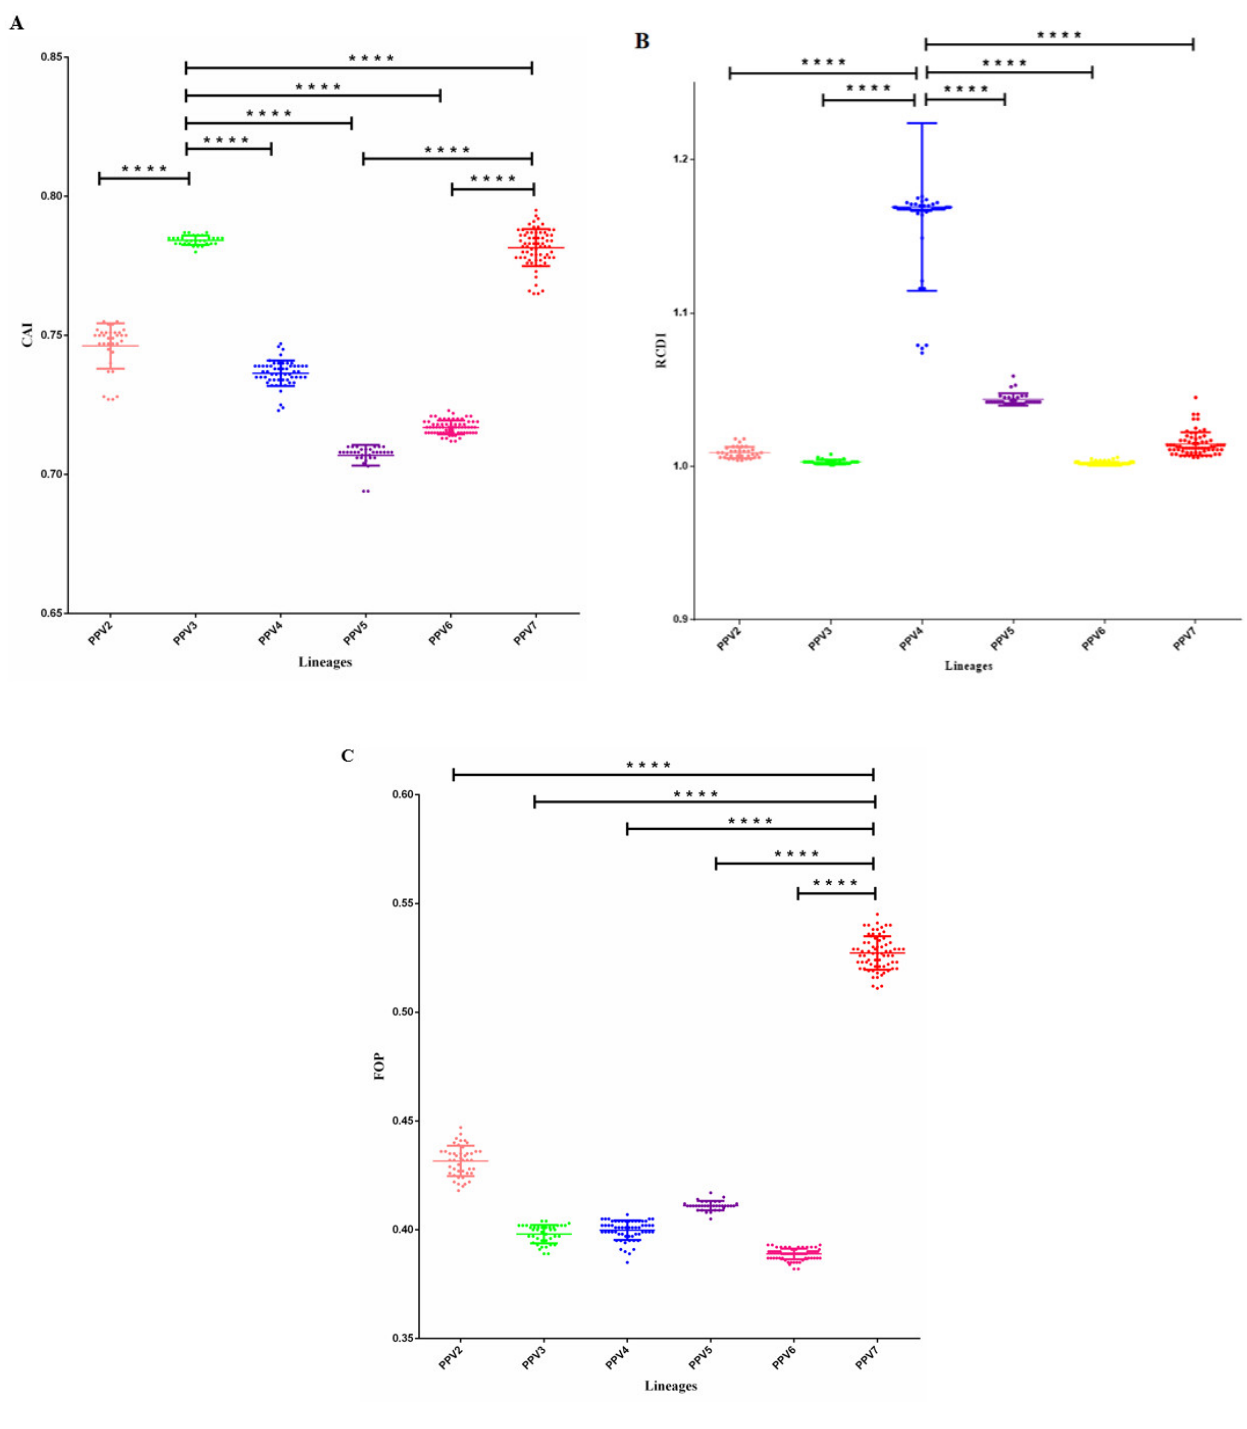
Figure 3. ( A ): CAI scatter plots of structural protein gene from different sub-types of all PPV strains. The asterisk indicates a significant difference between labeled groups. ( B ): RCDI scatter plots of structural protein gene from different sub-types of all PPV strains. The asterisk indicates a significant difference between labeled groups. ( C ): FOP scatter plots of structural protein gene from different sub-types of all PPV strains. The asterisk indicates a significant difference between labeled groups ( p < 0.001 ****).